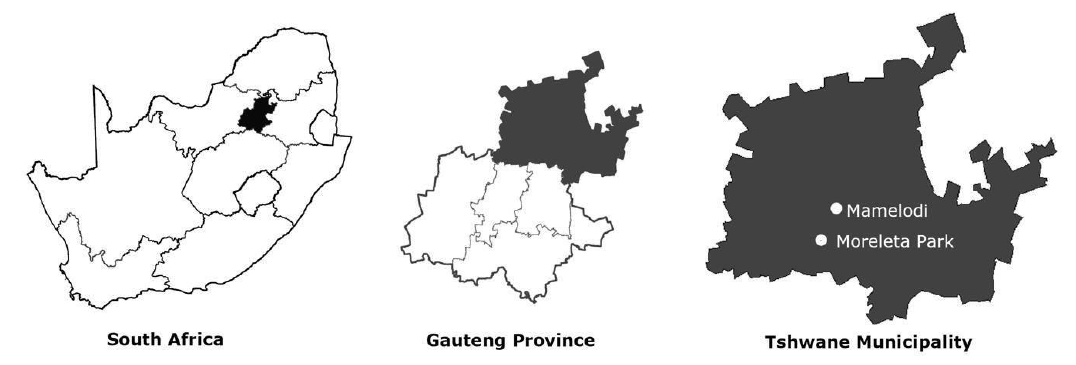
Figure 1. Maps showing location of case studies in South Africa, Gauteng and Tshwane